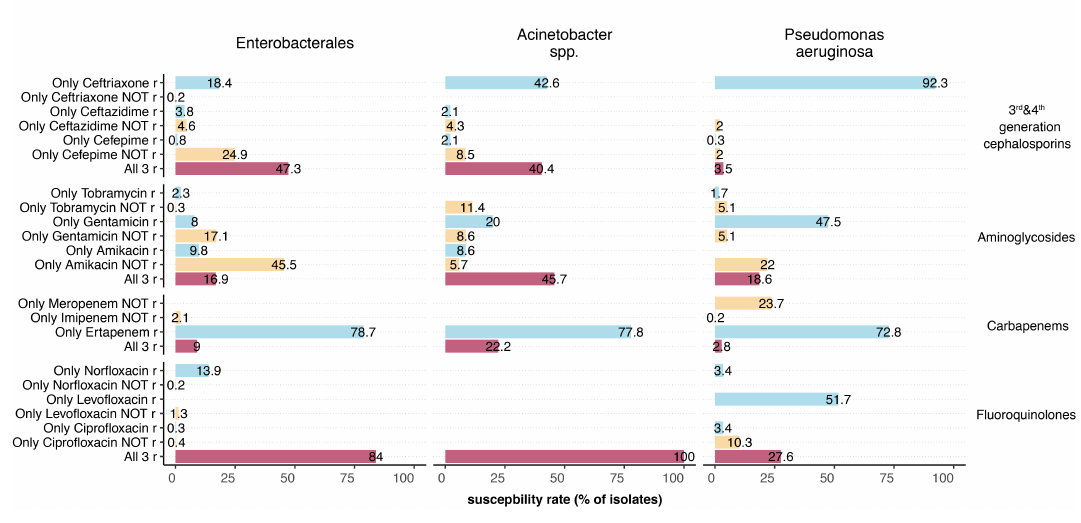
Figure S3: Summary of the cross-resistance in the different gram-negative microorganisms. To assess cross-resistance within an antibiotic category, only isolates for which all of the most frequently tested antibiotics of a group were analysed were included in the analysis. For the number of isolates included per antibiotic category, see Table S3. Colour code indicates how many antibiotics of the antibiotic category the iso- lates are resistant (blue, 1 out of 3; orange, 2 out of 3, red, 3 out of 3). r,